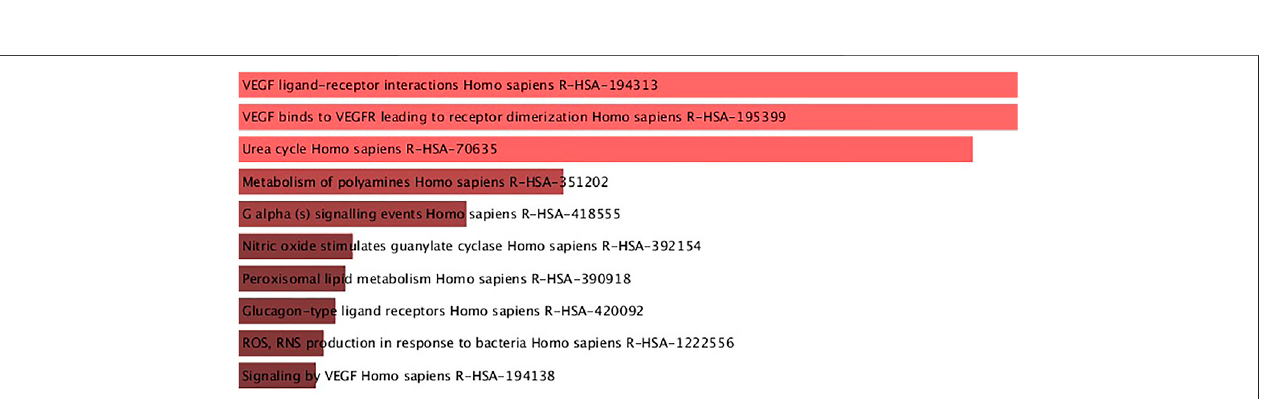
Frontiers in Pharmacology |